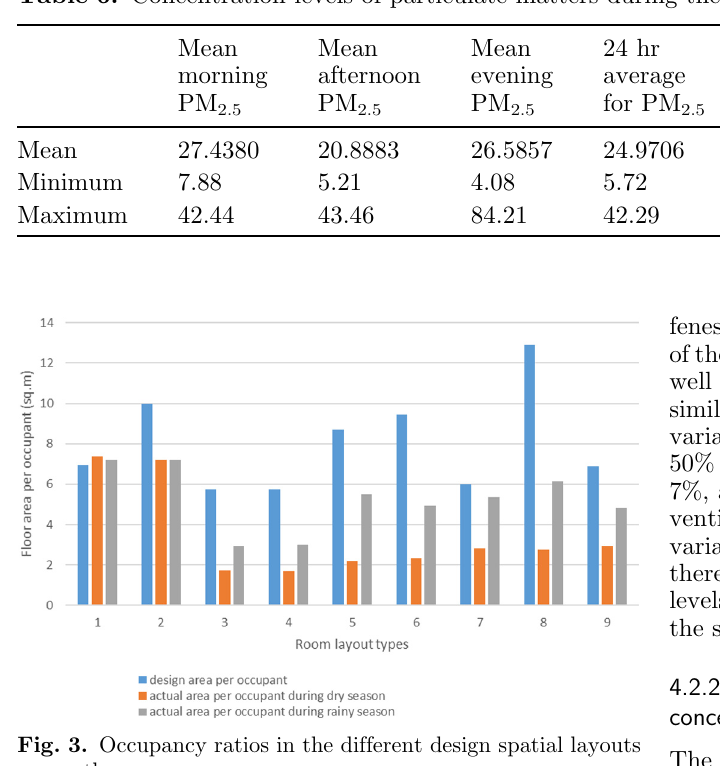
Table 6. Concentration levels of particulate matters during the wet